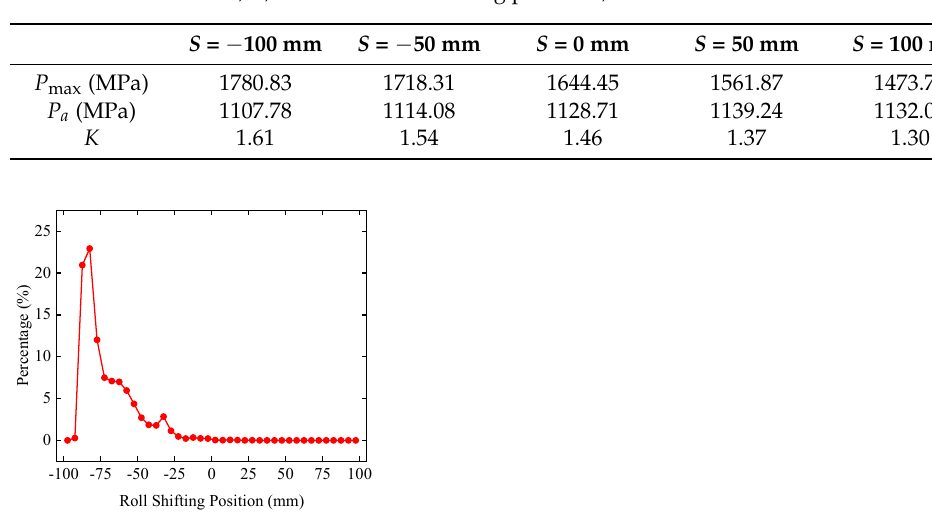
Figure 8. F2 stand work roll shifting position distribution.